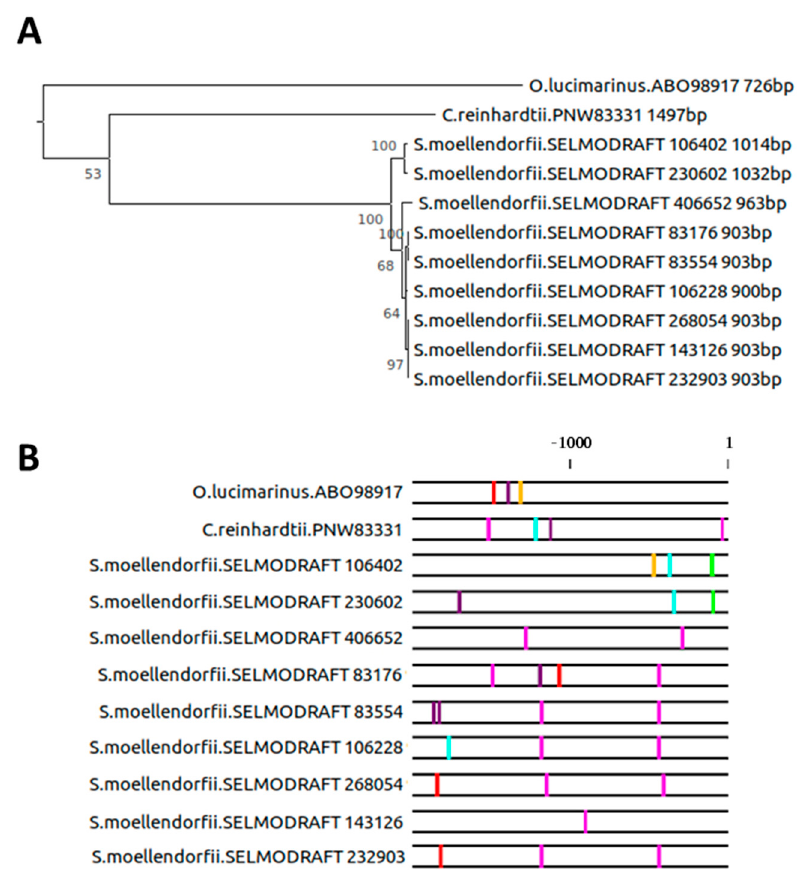
Figure 6. Phylogenic analyses of SAG12 and its promoter region Ostreococcus lucimarinus , Chlamydomonas reinhardtii , and Selaginella moellendorffii . ( A ) Phylogeny of SAG12 coding sequence indicating species, gene identification, and sequence length and ( B ) 2000 bp region adjacent to the ATG start codon annotated for the presence of W-boxes (T/C TGAC T/C), A-boxes (TACGTA), T-boxes (AACGTT), C-boxes (GACGTA), and G-boxes (CACGTA). W-boxes in sense (Pink), W-boxes in anti-sense (Purple), A-boxes (Green), T-boxes (Cyan), C-boxes (Yellow), and G-boxes (Red).